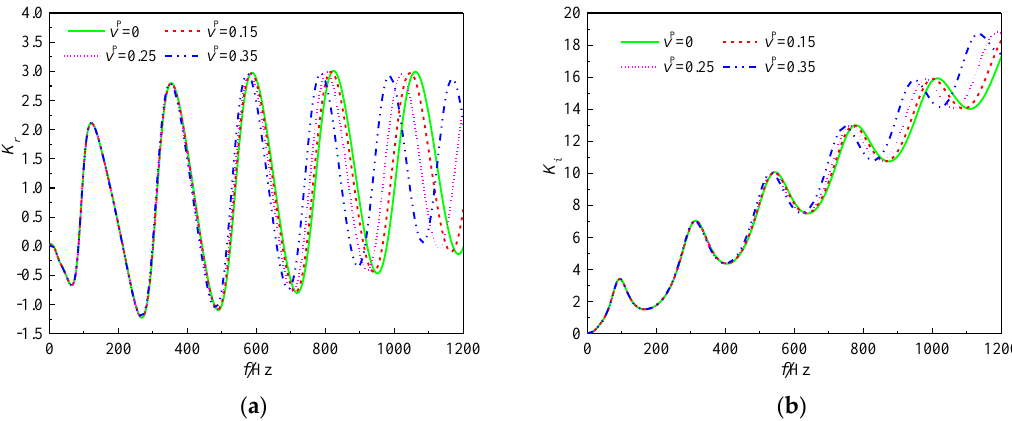
Figure 3. Variation of dynamic impedance with pile Poisson’s ratio: ( a ) true stiffness and ( b ) equivalent damping.